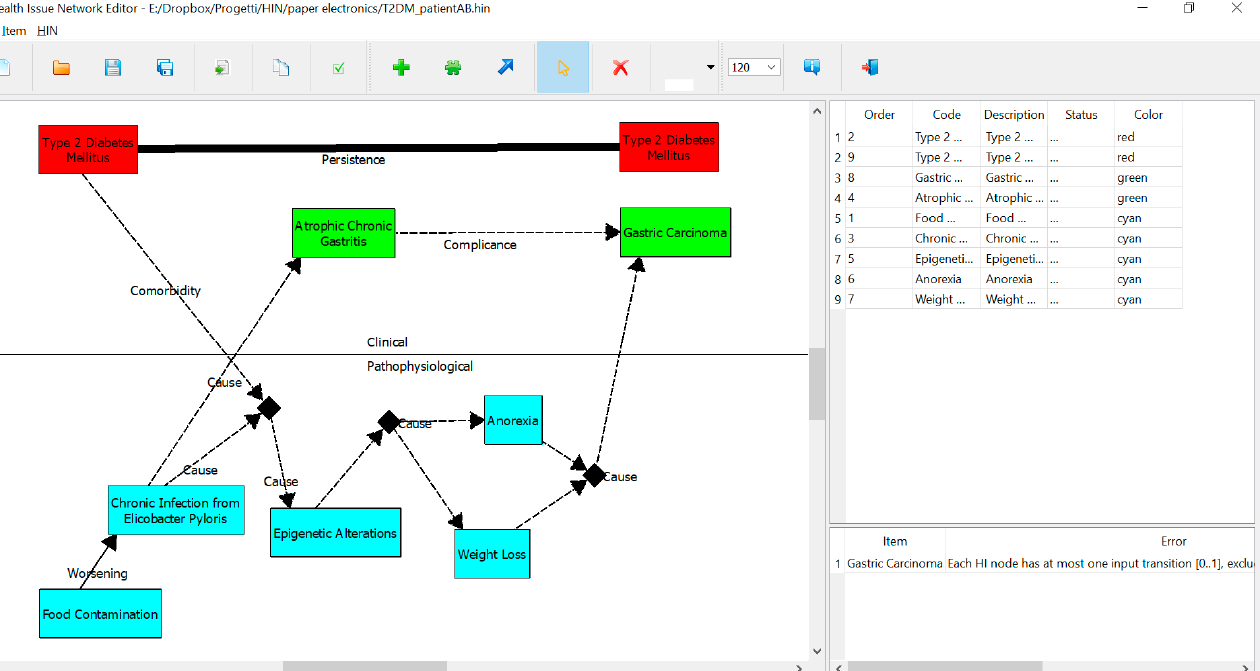
Figure 4. Screenshot of the main application window.